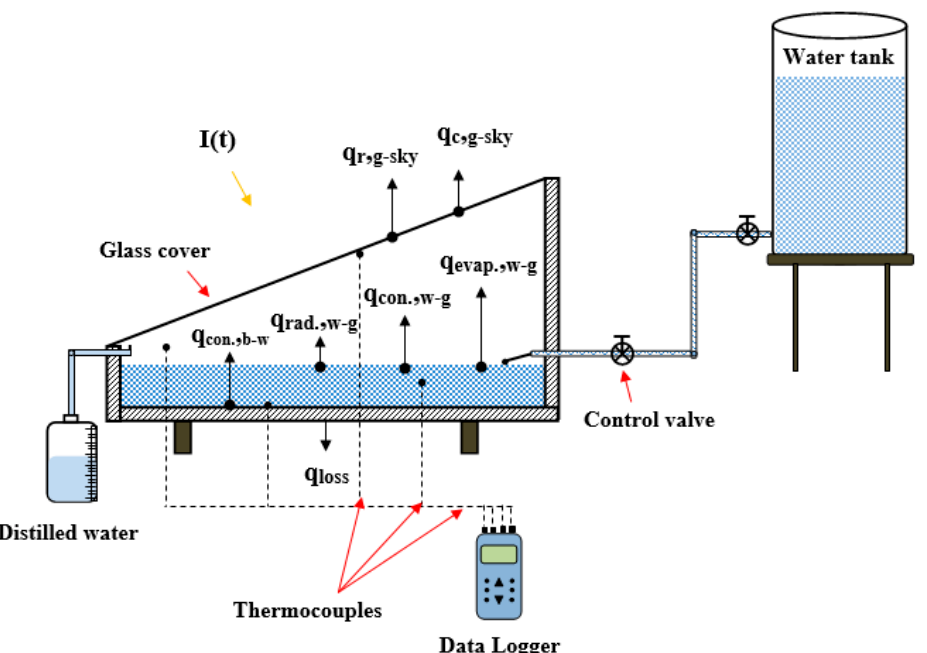
Figure 2. Schematic description of the experimental solar still.